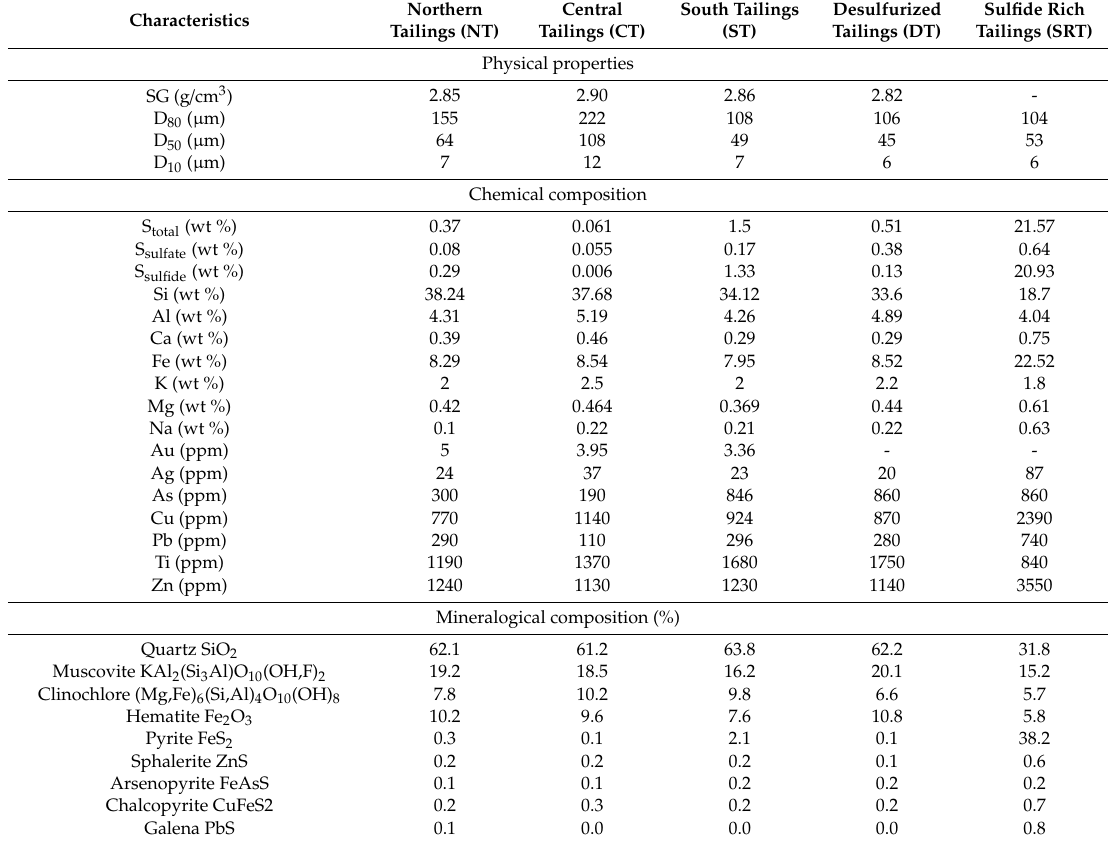
Table 2. Physical, chemical and mineralogical composition of the Tiouit tailings.